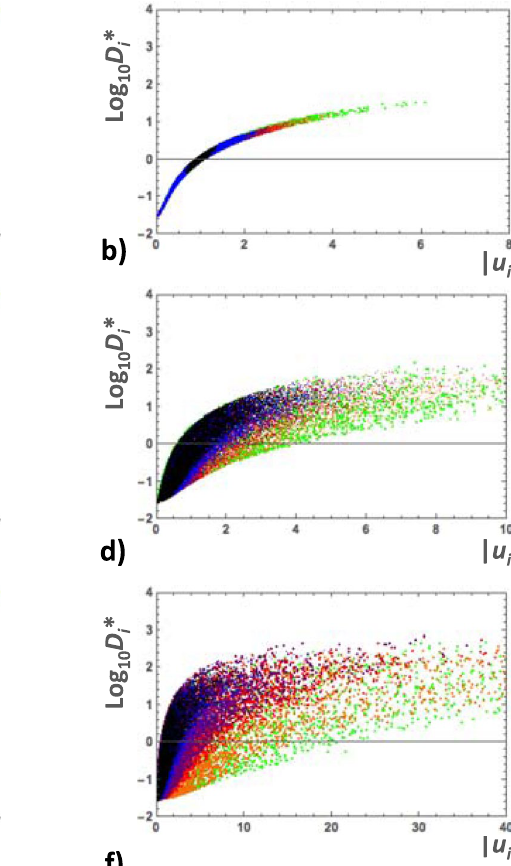
is fundamentally caused by its dependence on the squares of ˆ u i